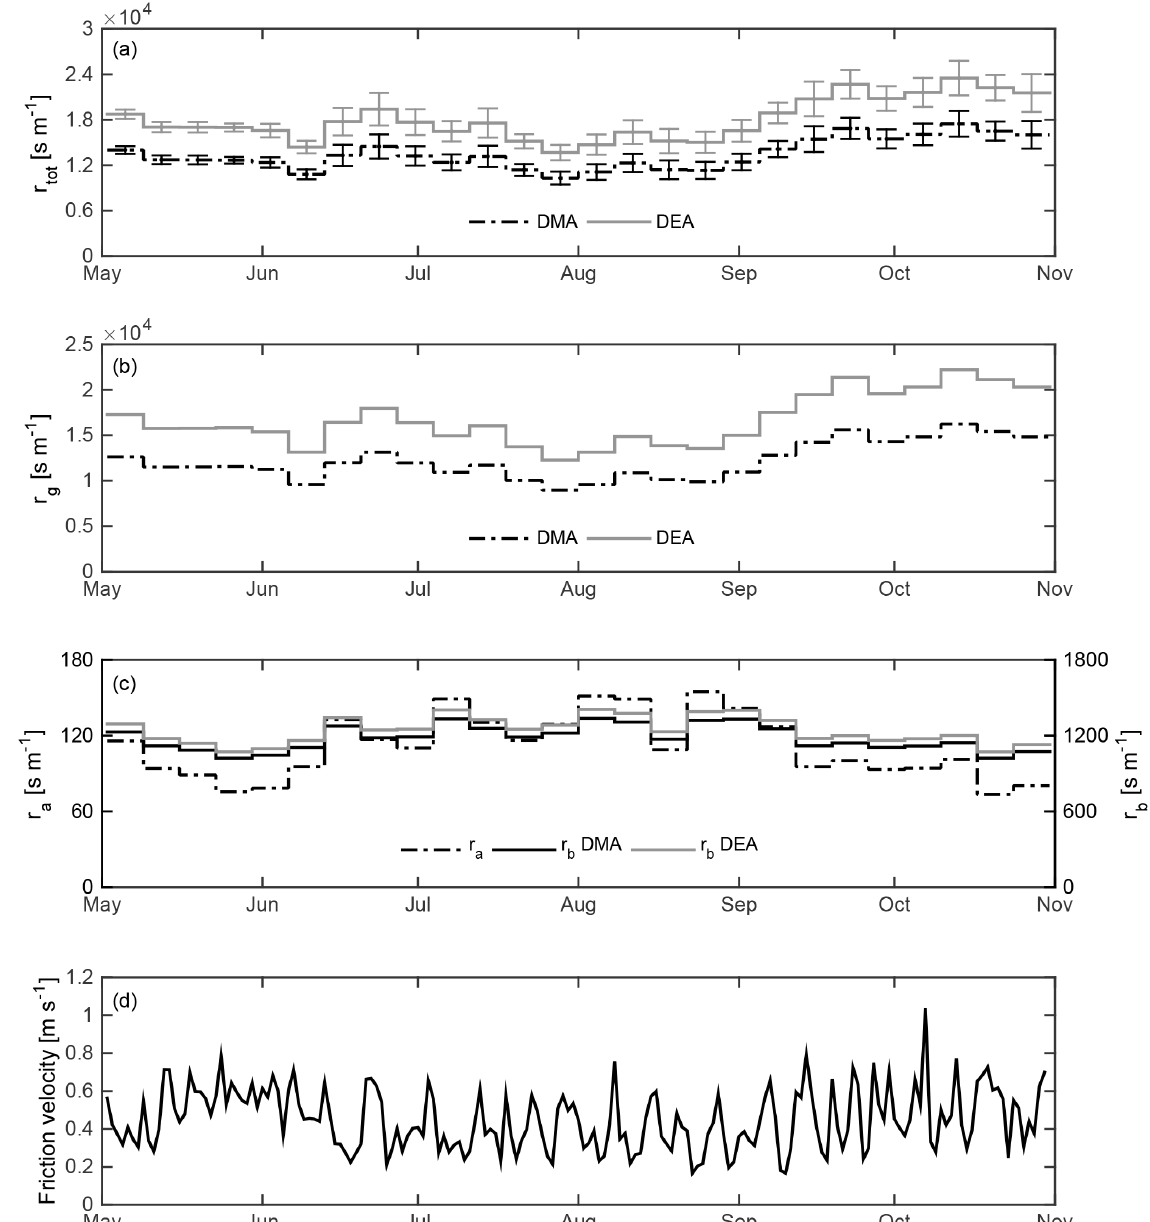
Figure 4. Total resistance ( r tot , sm − 1 ) of dimethylamine (DMA) and diethylamine (DEA) and its components: soil resistance ( r g , b ) aerodynamic resistance ( r a , sm − 1 , c ), and quasi-laminar resistance ( r b , sm − 1 , b ). Soil resistance ( r g , sm − 1 ) is calculated using 0.05m soil depth. In panel (d) the daily mean of above-canopy friction velocity (m s − 1 ) from May 2011 to October 2011 is shown. The error bars in panel (a) show ±